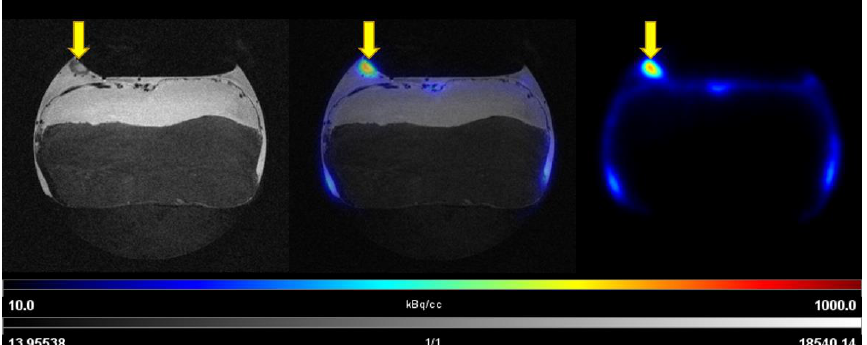
Figure 6. Representative images of 2-[ 18 F]FDG PET/MRI on EDD18 using the HT29 CAM-xenograft model. PET imaging was performed 60 min after injection of 8.94 MBq 2-[ 18 F]FDG into a CAM-vessel on EDD18. Left: T2-weighted TurboRARE image, right: PET, middle: fused PET and MR (axial planes are shown).